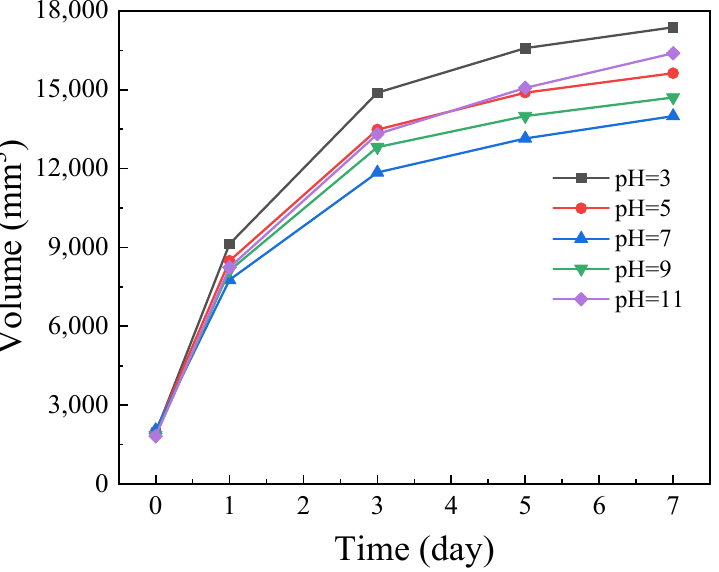
Figure 8. The change in volume of OIM@PAM immersed in various pH test solutions for 7 days. The internal micro images of the freezing-drying OIM@PAM after a 168 h release test